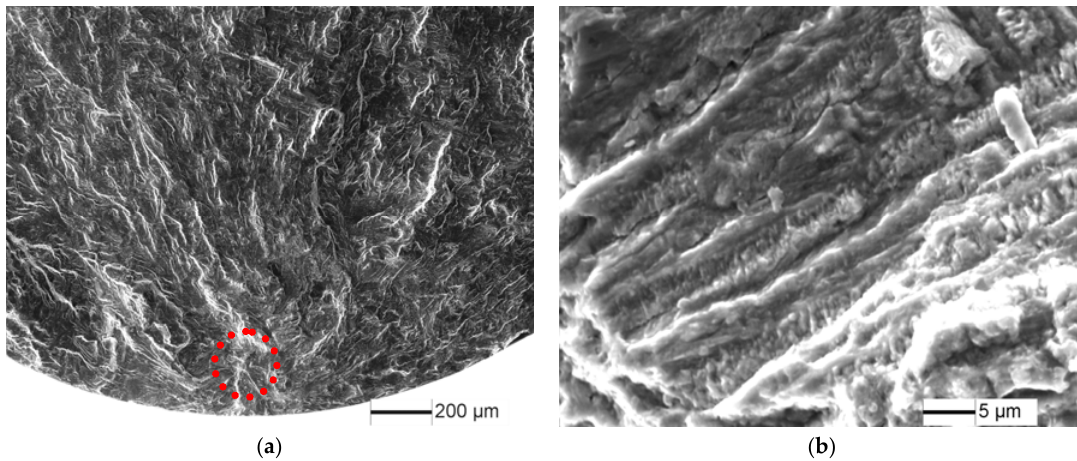
Figure 5. Fatigue fracture surface of TC21 titanium alloy with basketweave of 60 µ m at σ = 500 MPa, N = 6.66 × 10 6 cycles: ( a ) fatigue crack initiation site; ( b ) high magnification morphology.